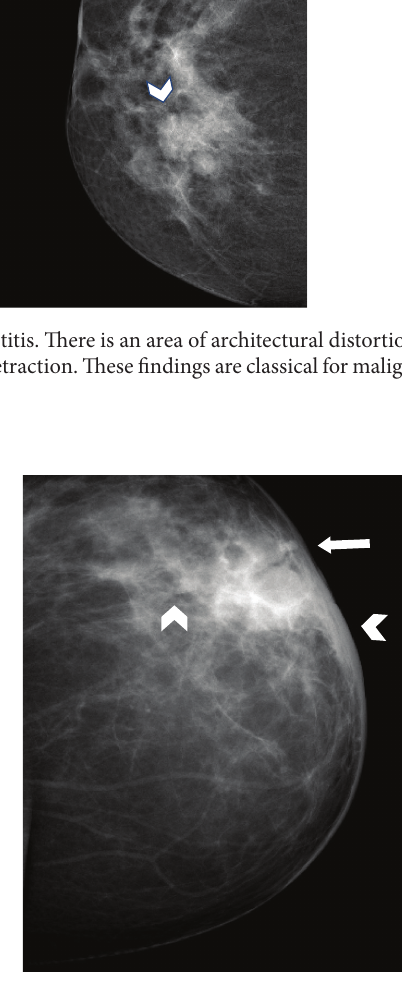
Figure 2: Single view of left breast. Nodular increase in retroareolar density with architectural distortion, parenchymal edema, periare- olar skin thickening, and depressed